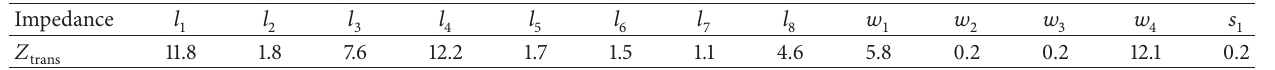
Table 2: Dimensions of artificial transmission lines of 𝑍 trans (unit: mm).